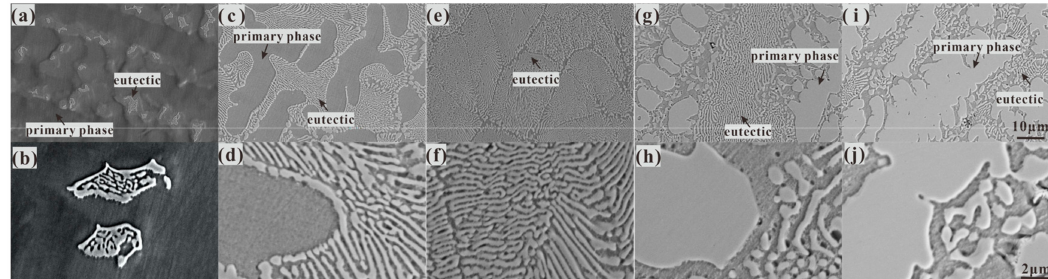
Figure 2. SEM images of CrCoNiTa x under as-cast microstructure; ( a , b ) = 0.1; ( c , d ) x = 0.3; ( e , f ) x = 0.4; ( g , h ) x = 0.5, ( i , j ) x = 0.7. Primary phase and eutectic under different compositions are